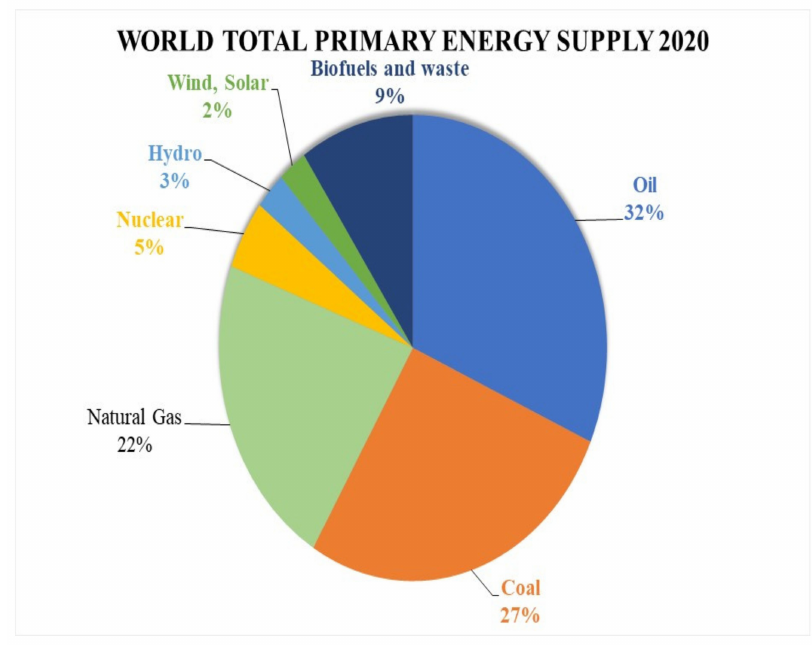
Figure 3. Distribution of various energy supply